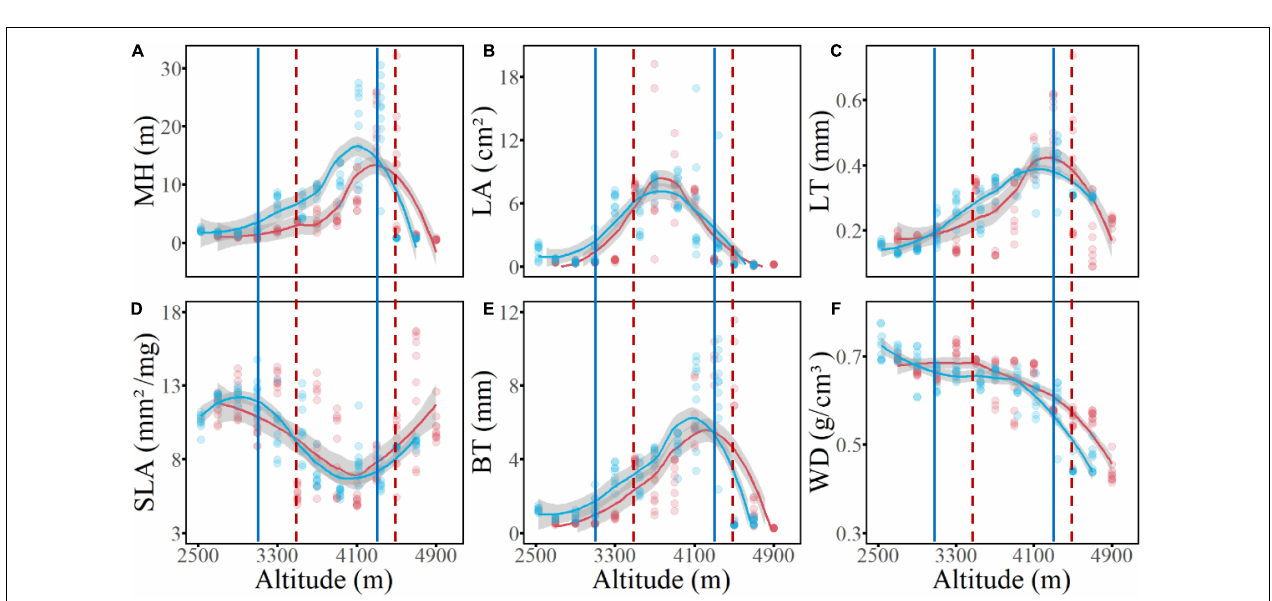
FIGURE 4 | The elevational patterns of community phylogenetic (red) and functional (blue) structure on the west (A) and east (B) slopes of the Hongla Snow Mountain. The asterisks indicate statistic significance ( P < 0.05).